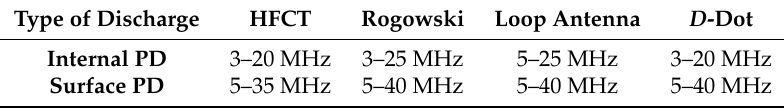
Table 2. Frequency spectra of PD signals captured by different